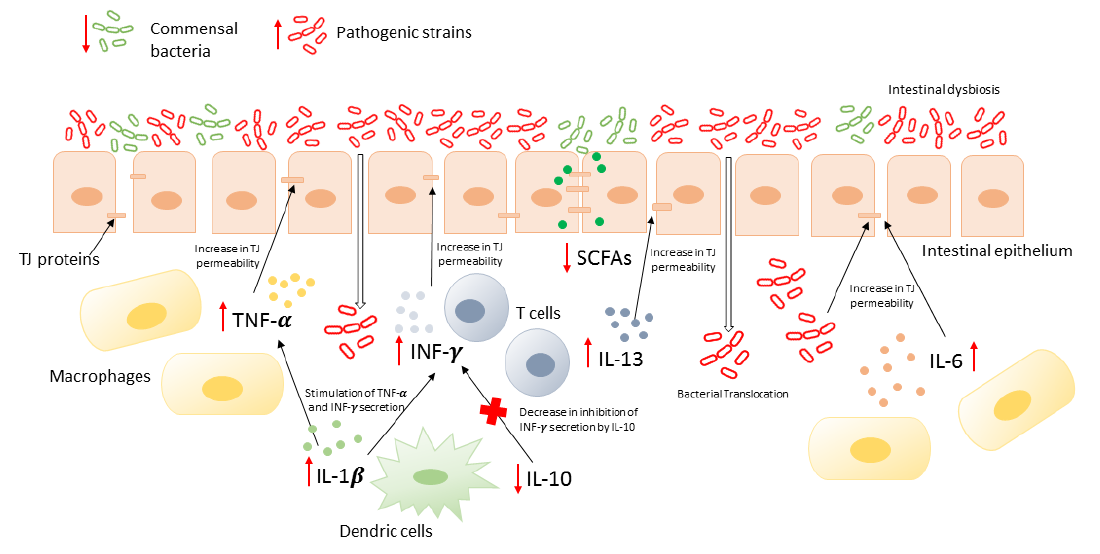
Figure 1. Consequences of bacterial